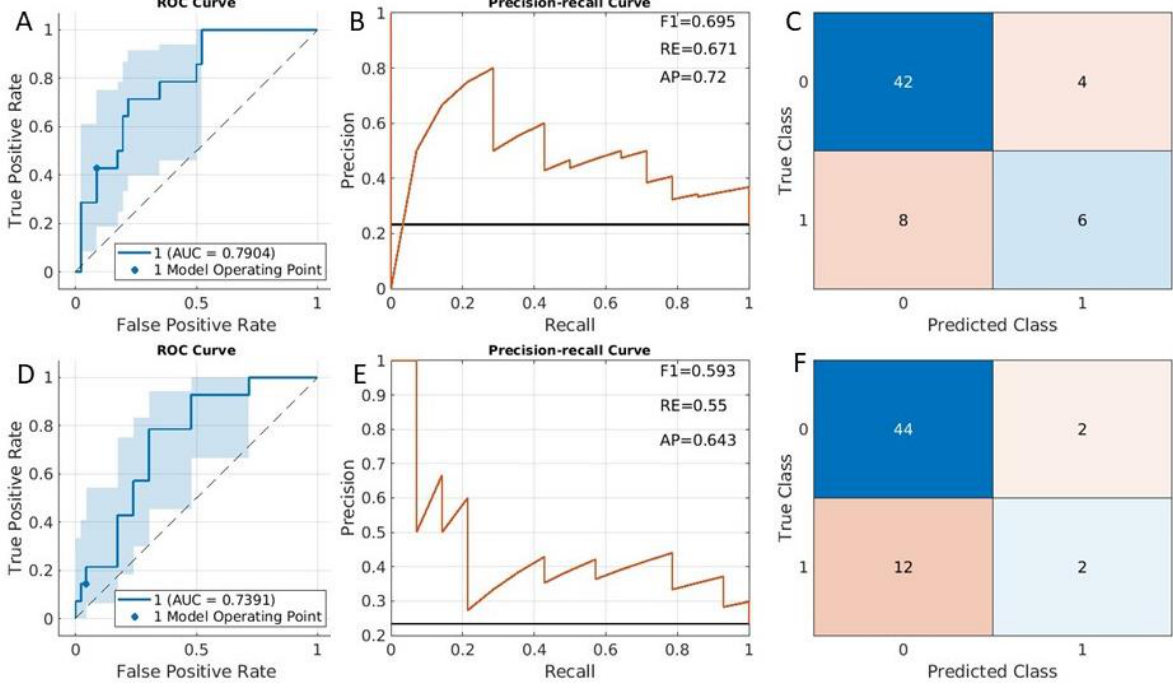
Figure 3. Deep myometrial infiltration prediction results from testing datasets. Summary receiver operating characteristic curves ( A , D ), precision – recall curve ( B , E ), and confusion matrix ( C , F ). ( A – C ) were obtained from the fitcauto method, while ( D – F ) were from the LASSO method. RE: average recall value. AP: average precision.